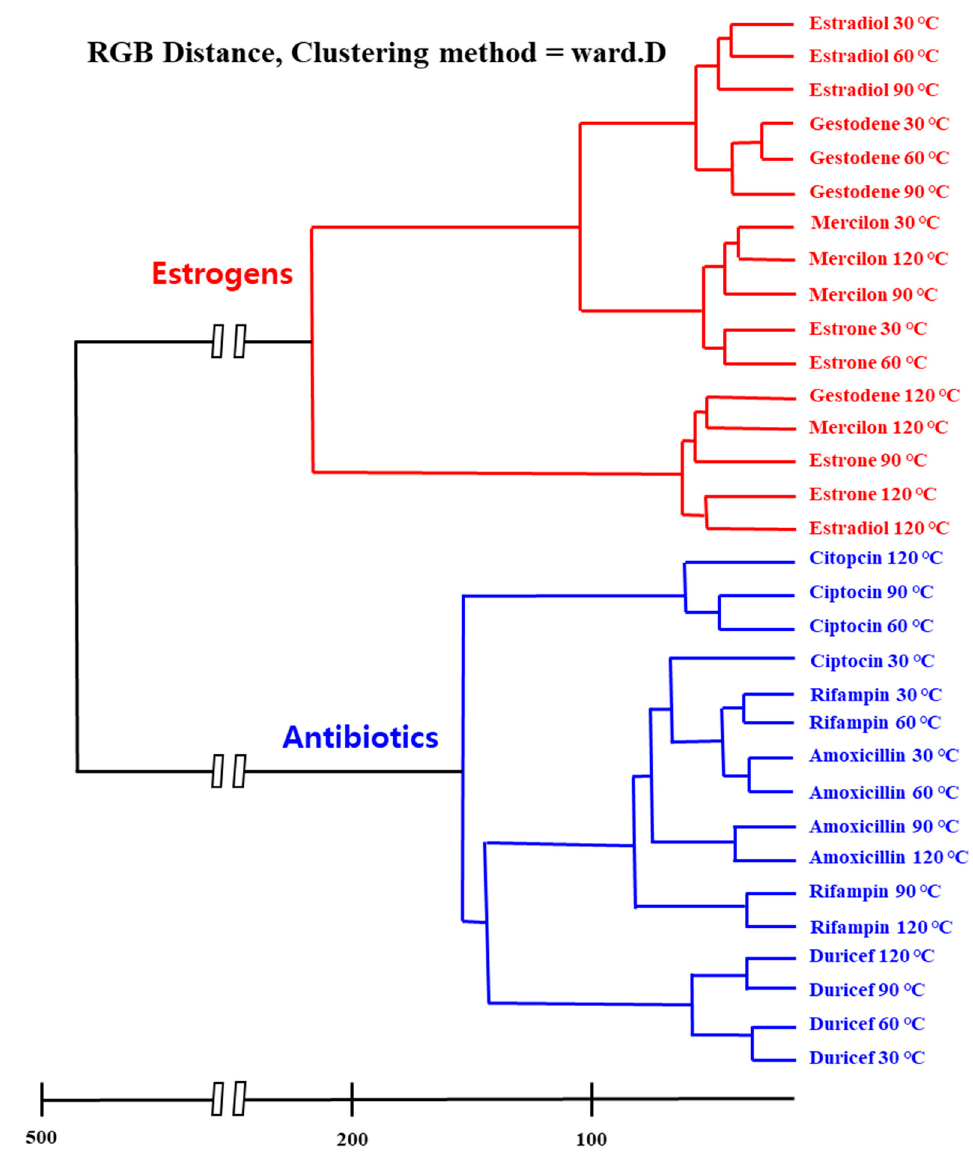
Figure 3. Hierarchical cluster analysis dendrogram for eight types of medical chemicals using the Ward.D linkage method, which is based on the linear model criterion of least squares. The Euclidean distance was set to the Δ RGB matrix which is made of the colorimetric shift values.